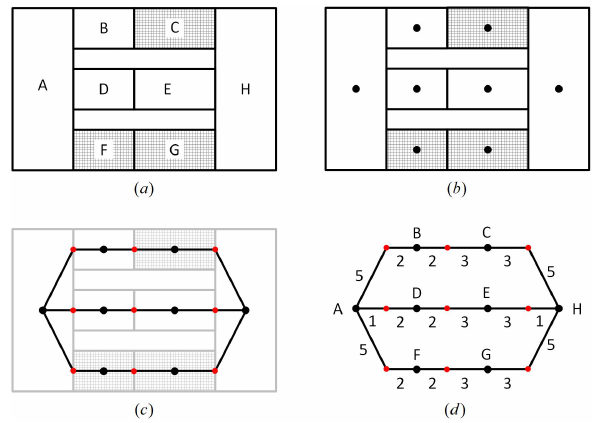
Figure 4. A navigation example, in which S C , S F , and S G are three sI-spaces. (a) All spaces. (b) Nodes extracted from spaces; (c) Navigation graph derived from spaces based on duality theory, in which the red dots are the extra vertices; (d) Navigation graph with distance.